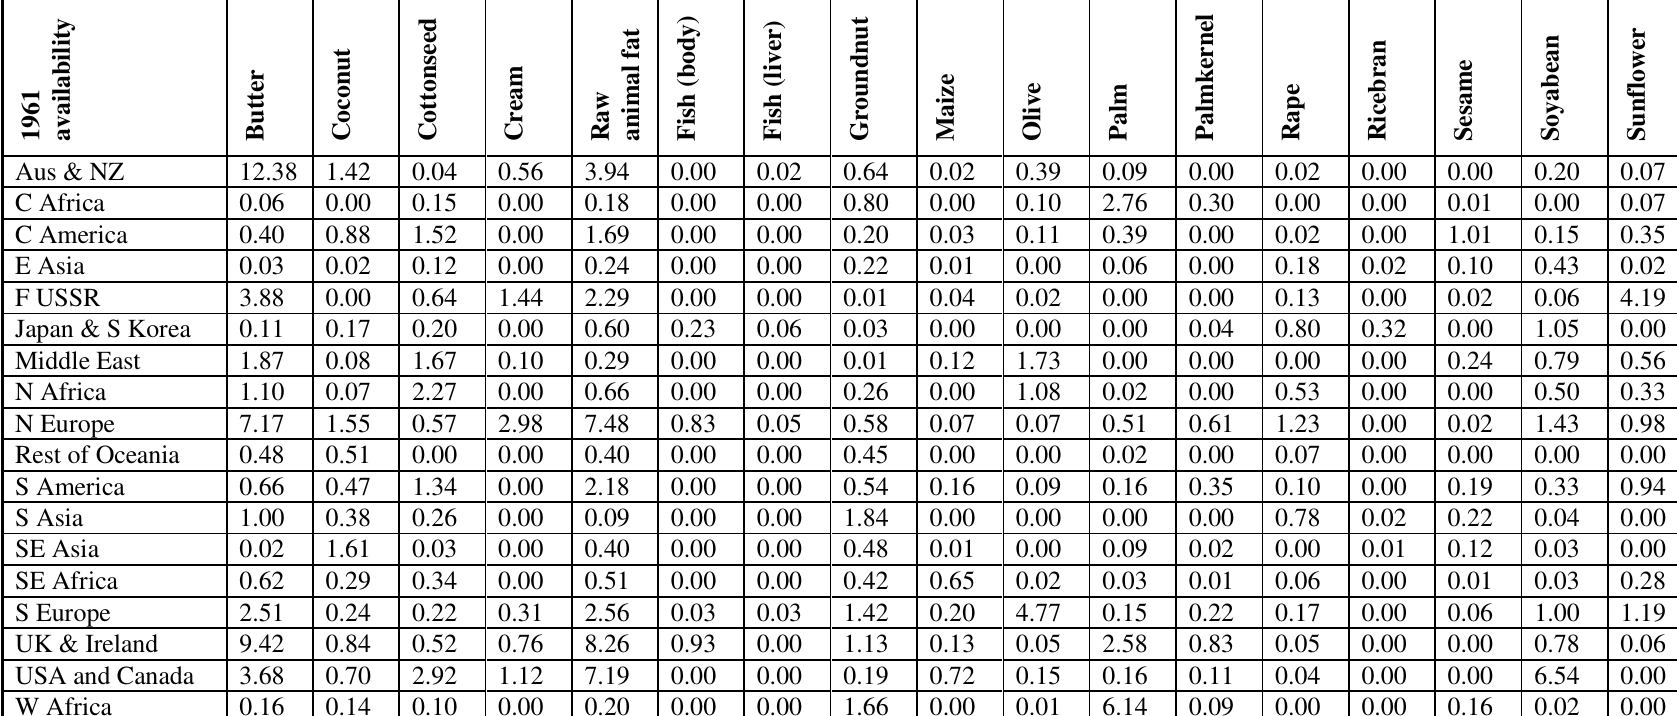
Table 1: World lipid availability, Kg/capita/year, 1961 (Source: FAOSTAT data, 2006).